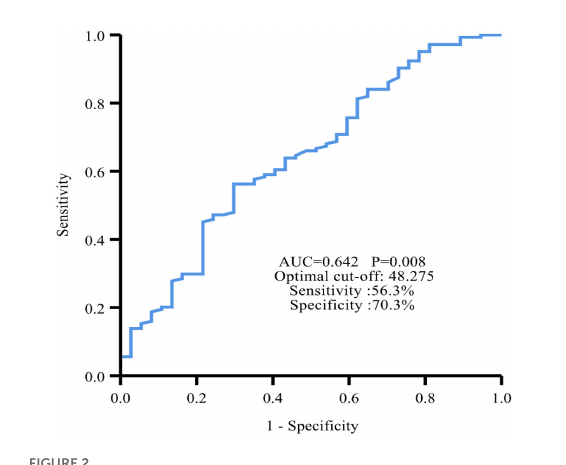
FIGURE2 Time-dependent ROC curve revealed that the best cut-off value of PNI to predict PFS was 48.275 with 56.3% sensitivity and 70.3%